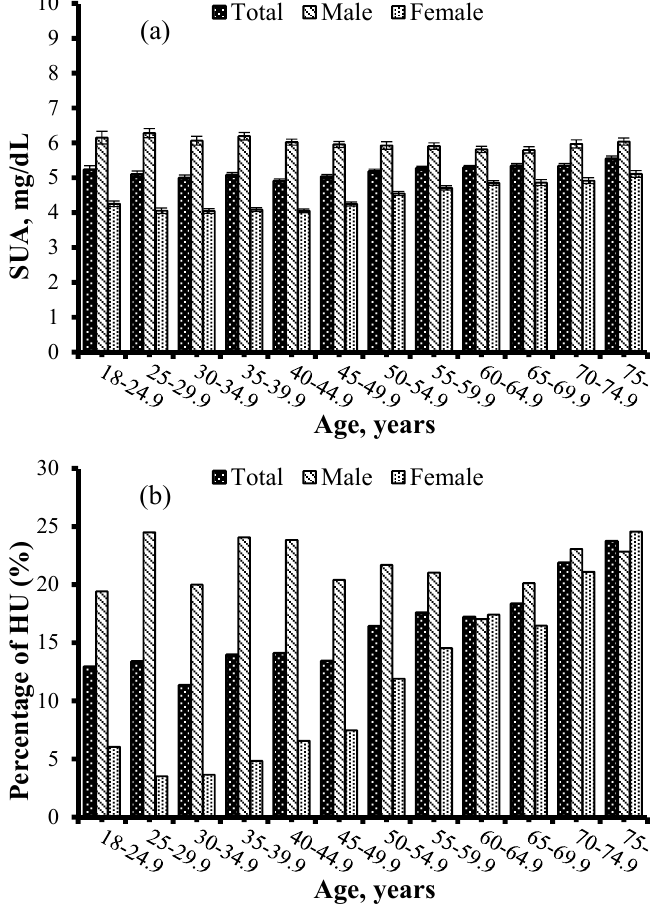
Figure 1. SUA concentrations ( a ) and crude prevalence of HU ( b ) for 7946 participants according to their age and gender. Data of SUA concentrations were expressed as means ± standard error (SE). SUA, serum uric acid; HU, hyperuricemia.